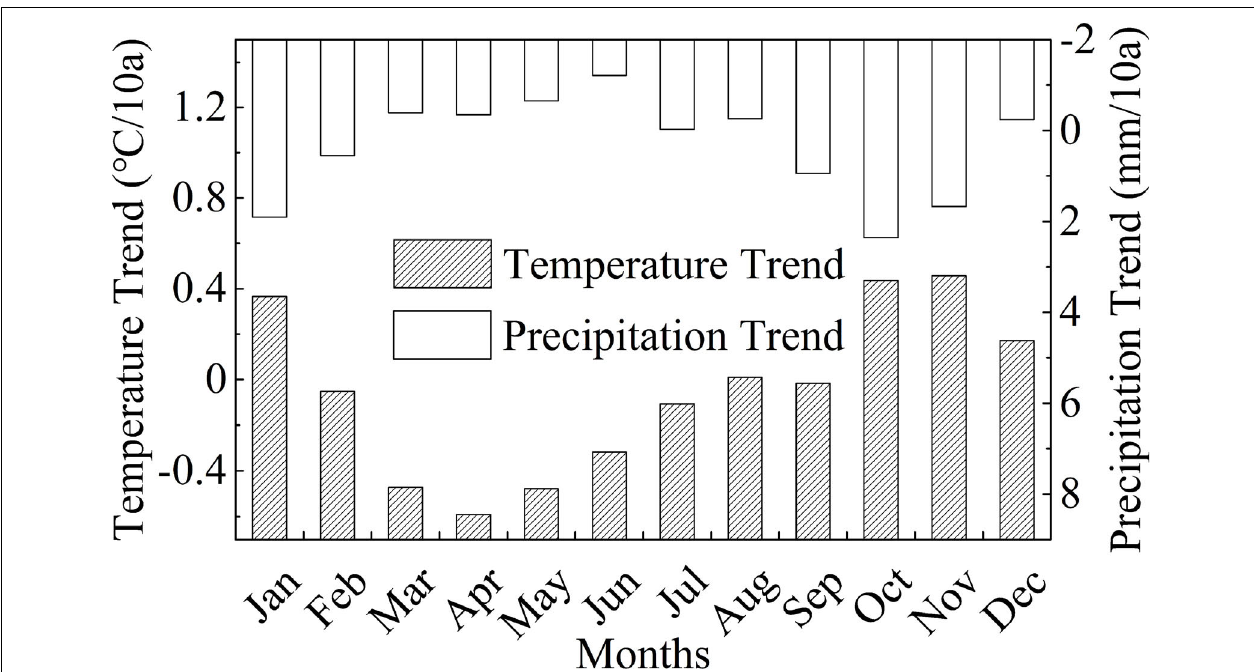
FIGURE 7 | Changes in the mean monthly air temperature and precipitation for all 19 stations from 1960 to 2019.